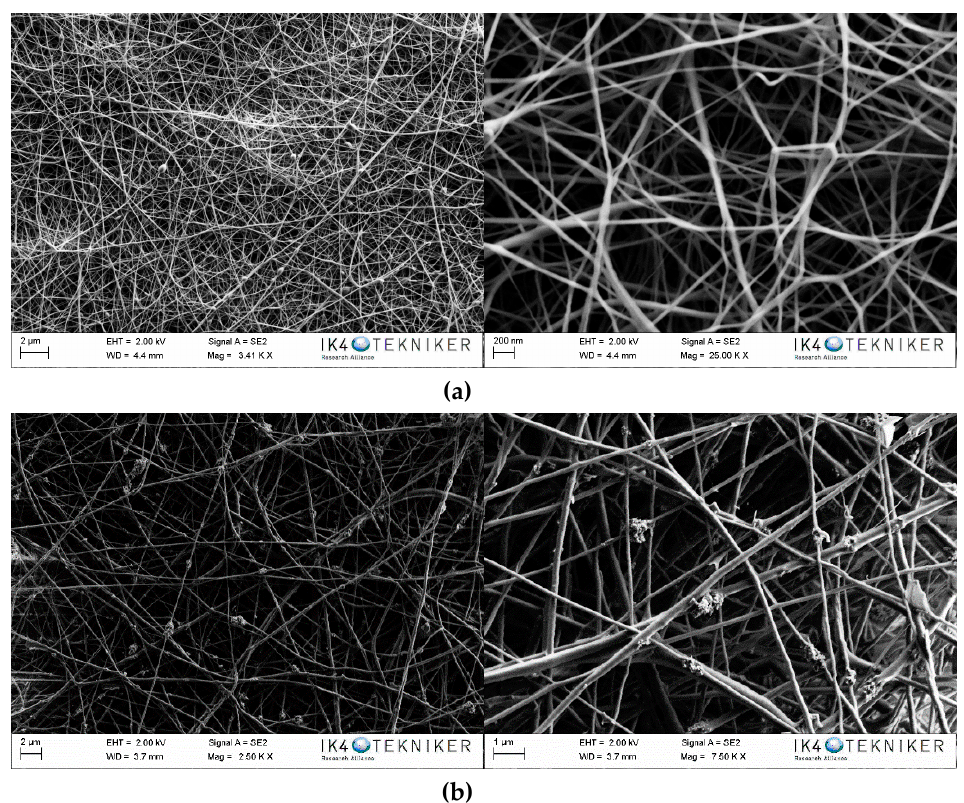
Figure 3. SEM images of ( a ) PA6 and ( b ) PA6/25 wt.% TiO 2 nanoparticles electrospun nanofibres. Table 1. Average diameter and areal weight of the PA6 and PA6/25 wt.% TiO 2 nanoparticle electrospun nanofibre membranes.